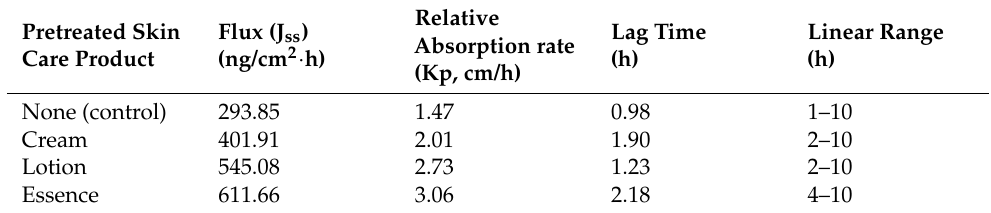
Table 3. Flux rates, relative absorption rates, and lag times of BIT applied to the minipig skin